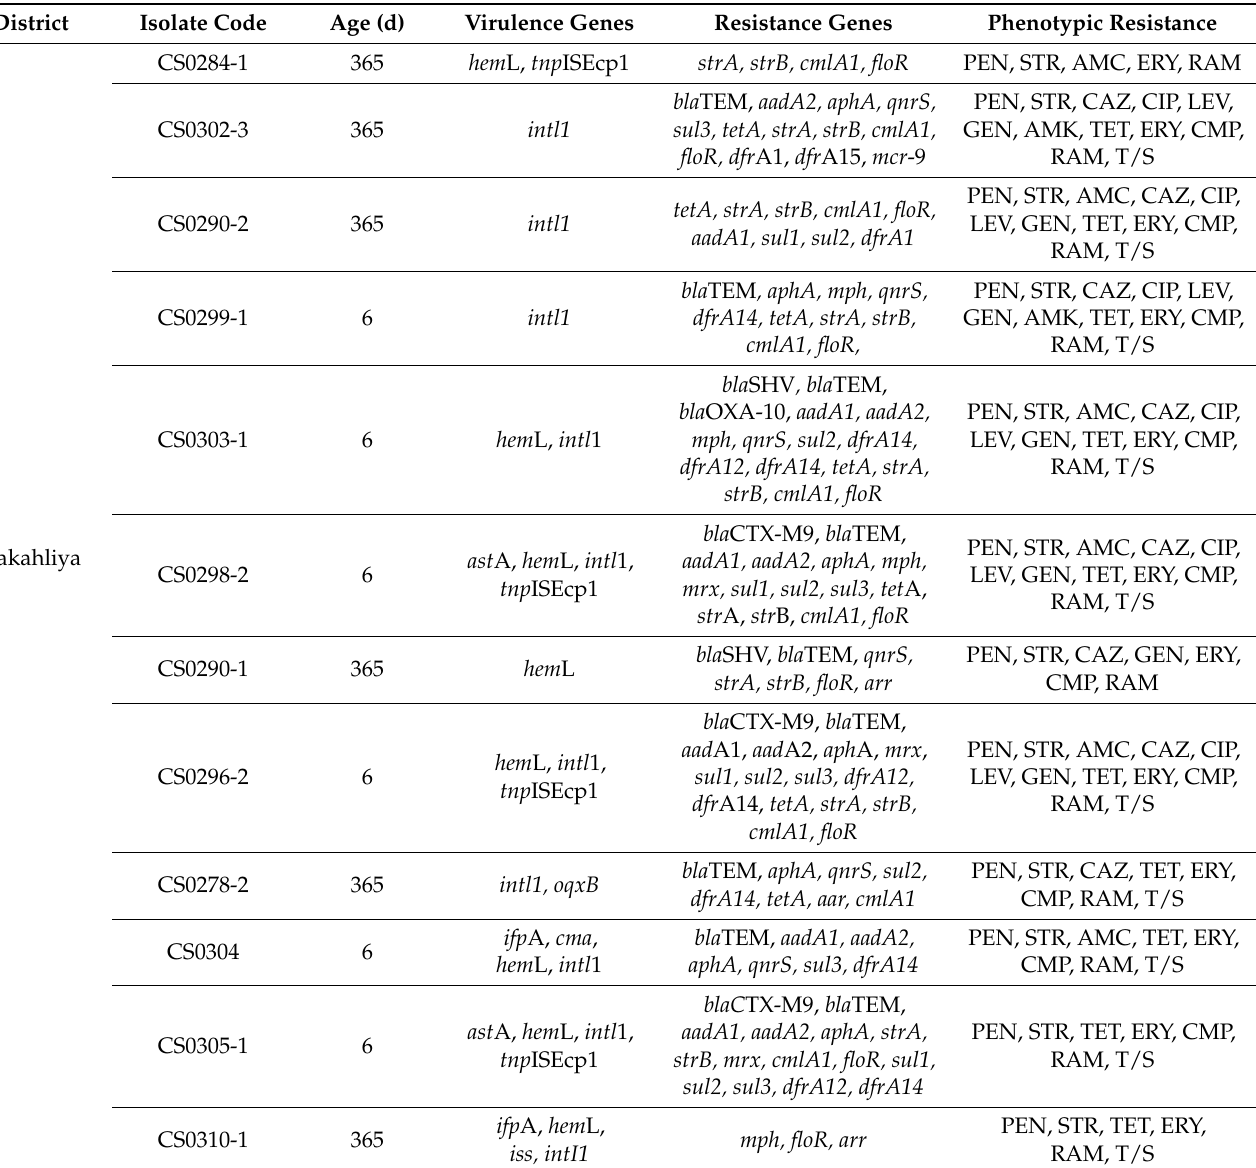
Table 4. Phenotypic and genotypic resistance profiles of E. coli isolates from healthy turkeys in five provinces in